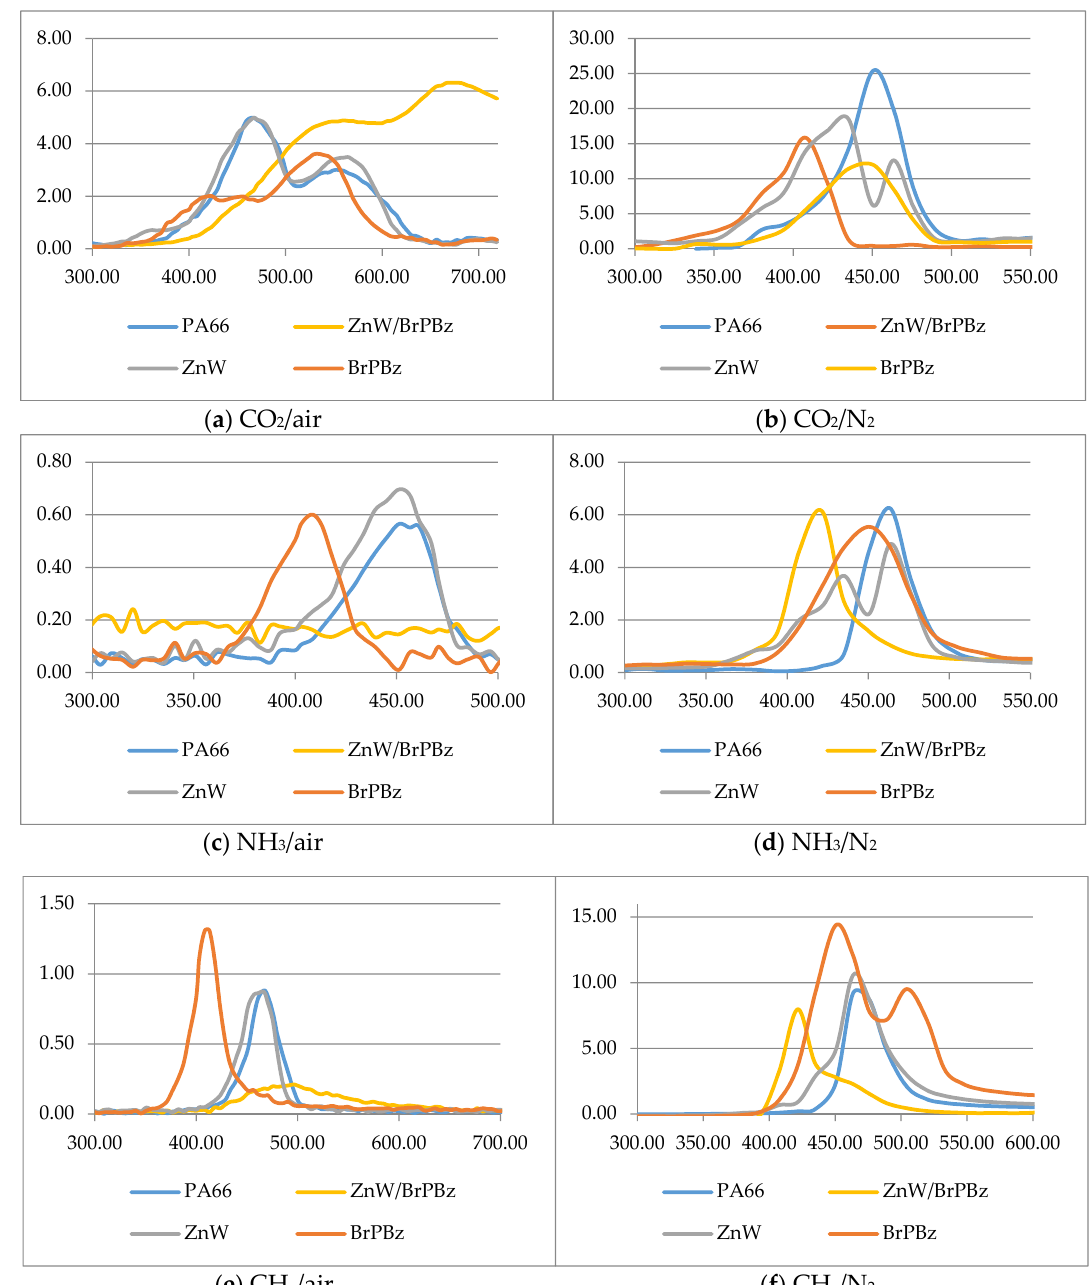
( b ) Figure 5. Exemplar 3D plots of TGA-FTIR data for ( a ) pure PA66 and ( b ) ZnW-BrPS under air. The CH x (2933 cm − 1 ), CO 2 (2357 cm − 1 ) and NH 3 (968 cm − 1 ) peak intensities as a function of temperature for all samples are shown in Figure 6. While the TGA responses in Figure 2 have